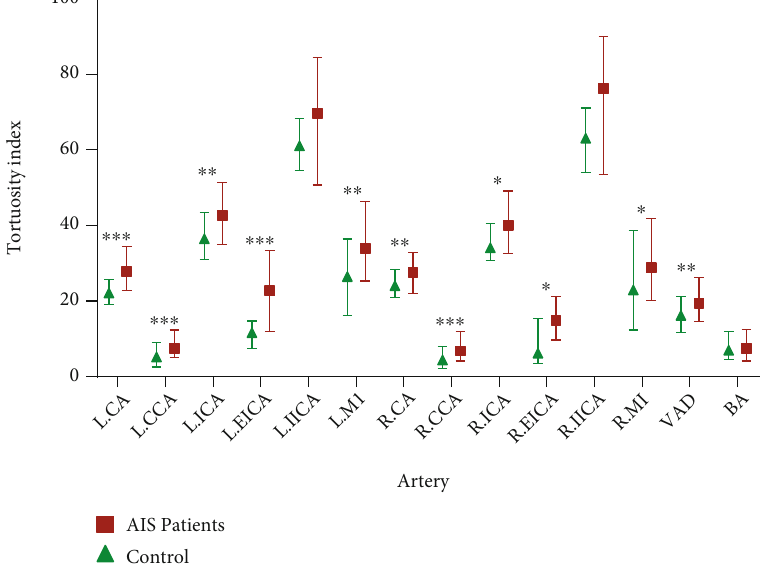
Figure 2: Forest plots show correlation analysis of arterial tortuosity with WMH severity in AIS patients. The adjusted odd ratio and P value represent the results of multivariate logistic regression analysis. Variables entered into analysis includes age, male, and hypertension. ∗ P < 0 : 05 ICA ( p = 0 : 001 ), right ICA ( p = 0 : 01 ), left EICA ( p < 0 : 001 ), right EICA ( p = 0 : 01 ), left M1 ( p = 0 : 001 ), right M1 ( p = 0 : 032 ), and VAD ( p = 0 : 001 ) (Figure 3 and Supplemen- tary Table 1). There was no statistically signi fi cant di ff erence between the groups in terms of left IICA, right IICA,